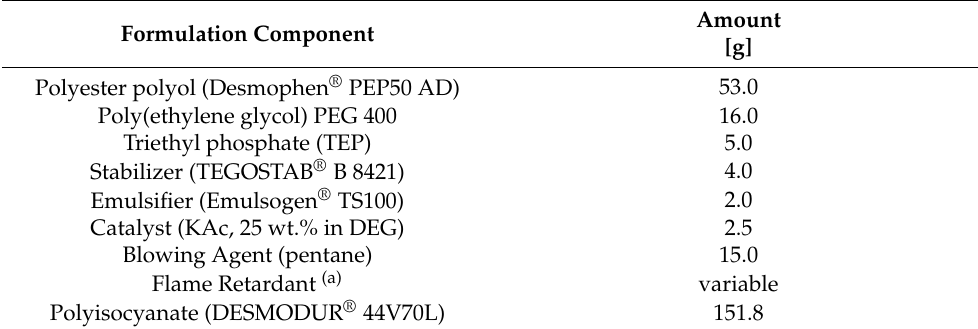
Table 2. General formulation of the polyisocyanurate (PIR) foams studied. Formulation